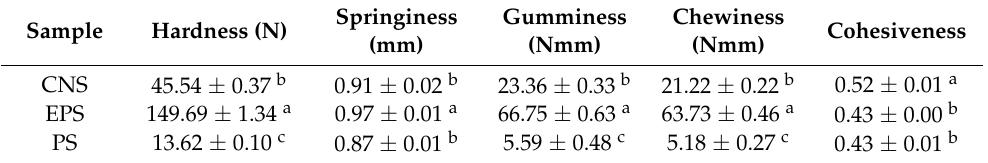
Table 2. Textural properties of native and